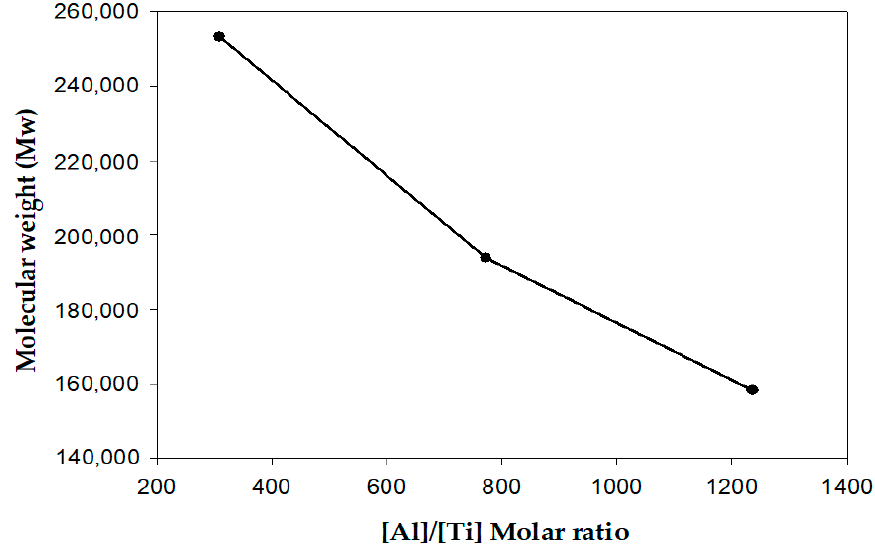
Figure 4. The relationship between the [Al]/[Ti] molar ratio and the molecular weight of polyeth- ylene.